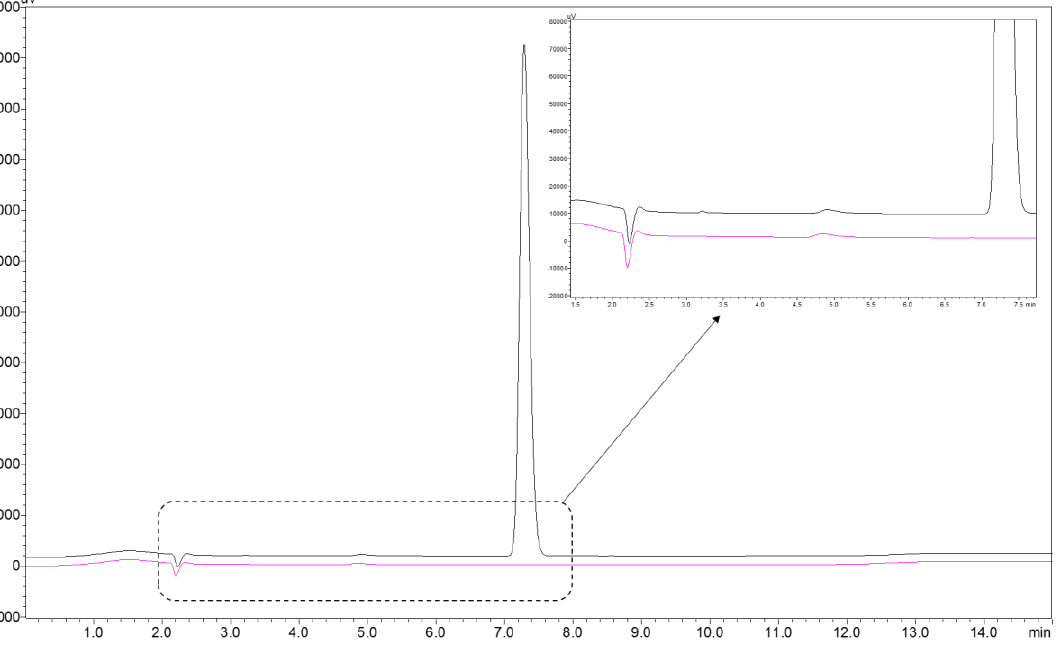
Figure 1. Reference chromatogram of pentobarbital sodium at a concentration of 150 µg/mL (black curve) and blank sample chromatogram (pink curve).